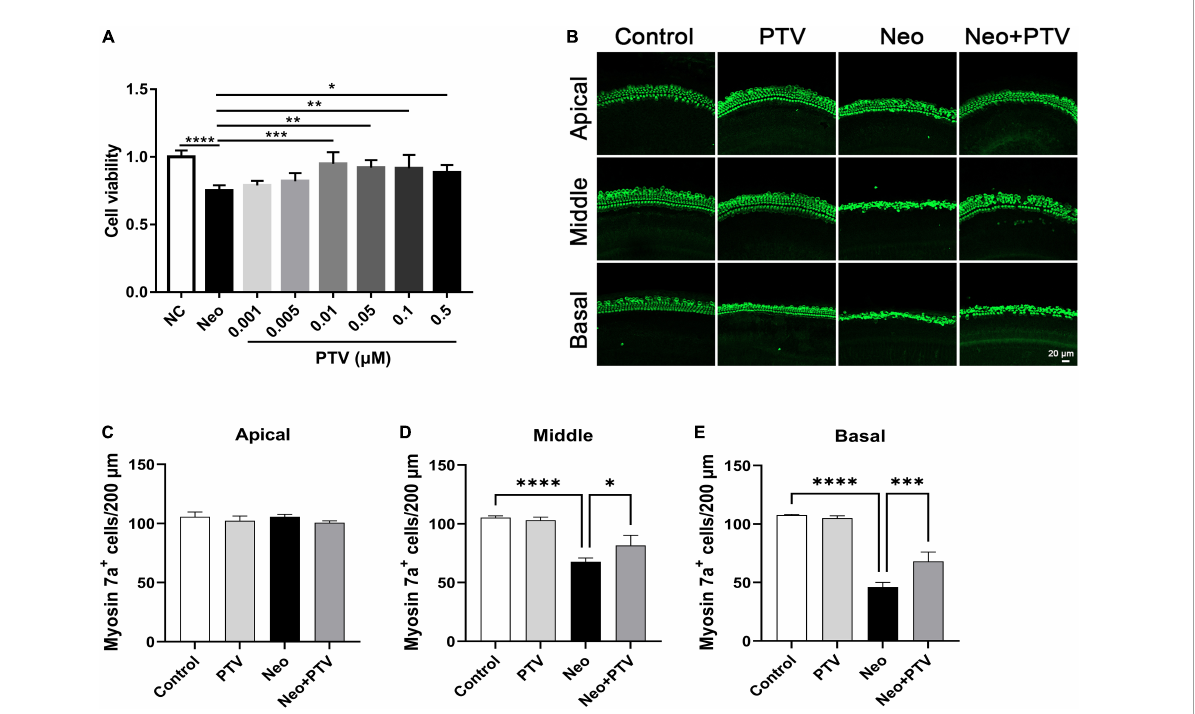
FIGURE1 PTV attenuates neomycin-induced HEI-OC1 cell damage and missing of hair cells in cochlear explants in vitro . (A) The CCK8 method was used to determine the protective effect of PTV (0.001, 0.005, 0.01, 0.05, 0.1, and 0.5 µ m) on neomycin-induced HEI-OC1 cell injury ( n = 6). (B) Immunostaining of hair cells in cochlear explants in the apical, middle, and basal turns with anti-myosin 7a antibody. Scale bars = 20 µ m. (C–E) Counting of the amount of hair cells per 200 µ m in inner ear in the apical, middle and basal turns ( n = 3). * p < 0.05, ** p < 0.01, *** p < 0.001, **** p <